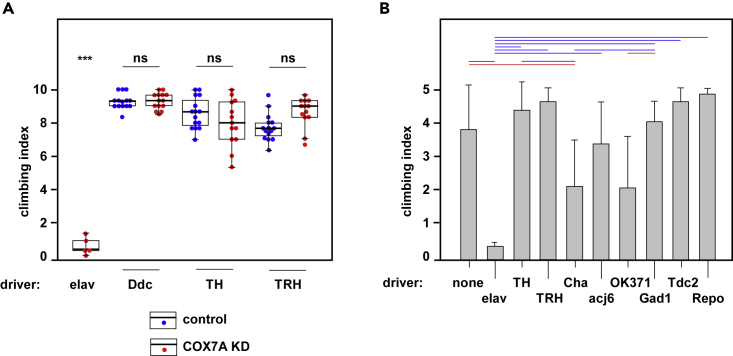
Locomotor Impairment Is due to COX7A Knockdown in Neurons of Specific Neurotransmitter IdentitiesClimbing index for COX7A-KD flies derived by crossing the indicated GAL4 driver or control males (homozygous or balanced, as indicated in Transparent Methods) to UAS-RNAiCOX7A; UAS-Dcr-2 females or (A, controls) to UAS-Dcr-2 females without the RNAi construct.(A) Boxplots indicate medians (bold lines), 25th and 75th percentiles (box limits), and 1.5 times the interquartile range (Tukey-style whiskers, truncated where they would cross the zero or maximum lines) for batches of 10 virgin female flies. Colored dots represent individual data points for each batch (means of three tests) as indicated. Significant differences (one-way ANOVA with Tukey post hoc HSD test), indicated as ∗∗∗, p < 0.001 for comparison with all other data classes, ns, p > 0.05 for the pairwise comparisons indicated. Other comparisons omitted for clarity. Note that the elav-GAL4 driver was included here as a positive control.(B) Means ± SD (n ≥ 4, except for repo-GAL4, n = 3) for batches of five virgin female flies. Statistical analysis (one-way ANOVA with Tukey post hoc HSD test; significant differences indicated by red and blue bars, denoting p < 0.05 and p < 0.01, respectively. For repeat experiments using Cha-GAL4 and OK371 drivers, alongside UAS-Dcr-2 controls, see Figures 3B and 3C. Note that TH-GAL4 drives expression only poorly, if at all, in a small subset of DA neurons that are, conversely, targeted by Ddc-GAL4 (Riemensperger et al., 2013); both drivers are therefore needed to cover all DA neurons. Based on GFP controls, drivers were active in cells of the predicted identity (Figures S7–S9), although the TRH-GAL4 driver did drive expression in a small number of TH-positive (i.e., DA) neurons (Figure S9B). Effects in DA neurons were not simply delayed (see Figure S10).